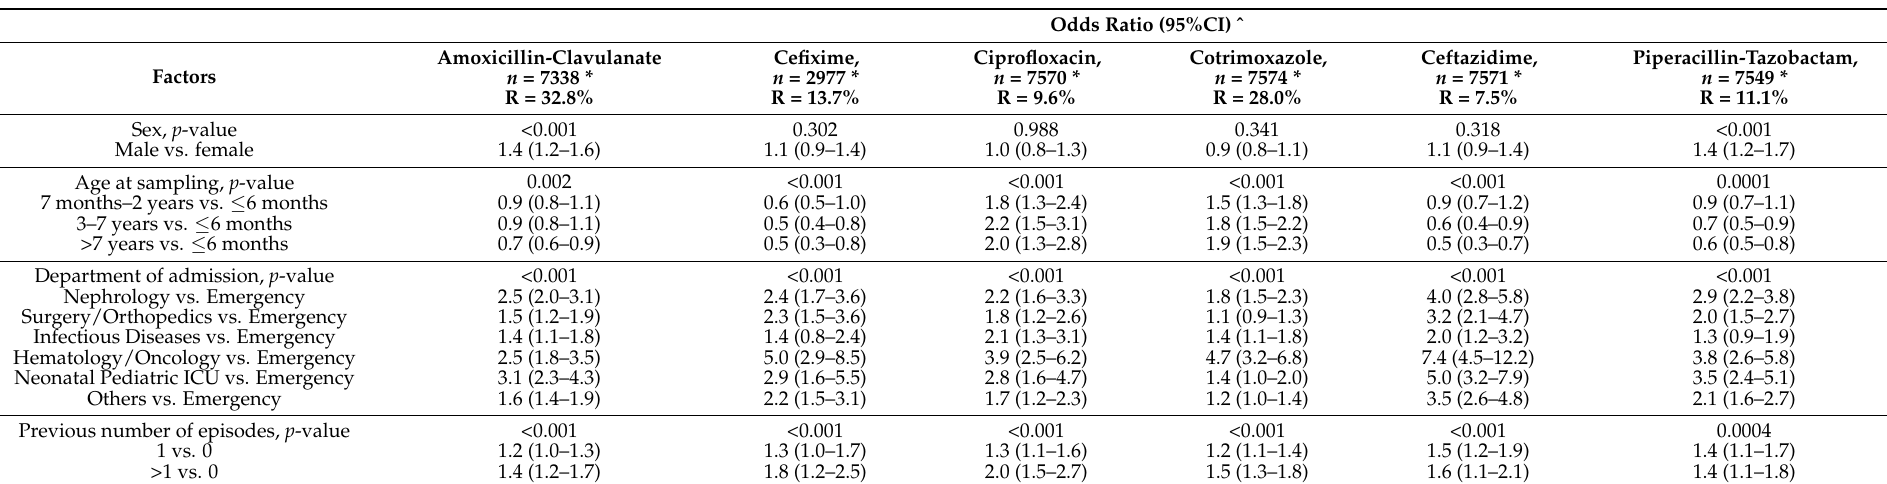
Table 2. Multivariable logistic regression models for resistance to different antibiotics among 4902 Escherichia coli and 2694 other Enterobacteriales